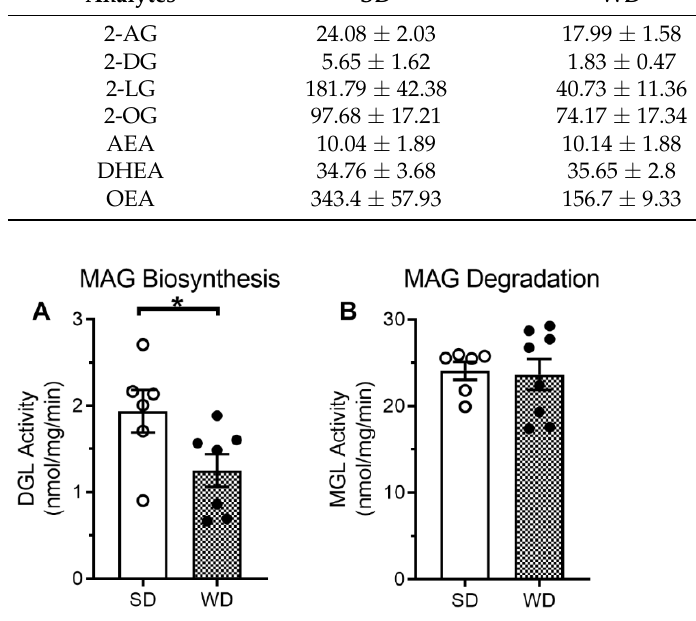
Figure 2. Changes in endocannabinoid enzymatic activity in the large-intestinal epithelium in mice fed WD. Mice fed WD for eight weeks had a significant reduction in the activity of MAG biosynthetic enzymes in the large-intestinal epithelium ( A ) with no changes in activity of the MAG degradative enzymes ( B ) when compared to mice fed SD. Data analyzed by two-tailed unpaired Student’s t-test; * = p < 0.05, n = 6 – 8 per condition. SD = standard diet, WD = Western diet.